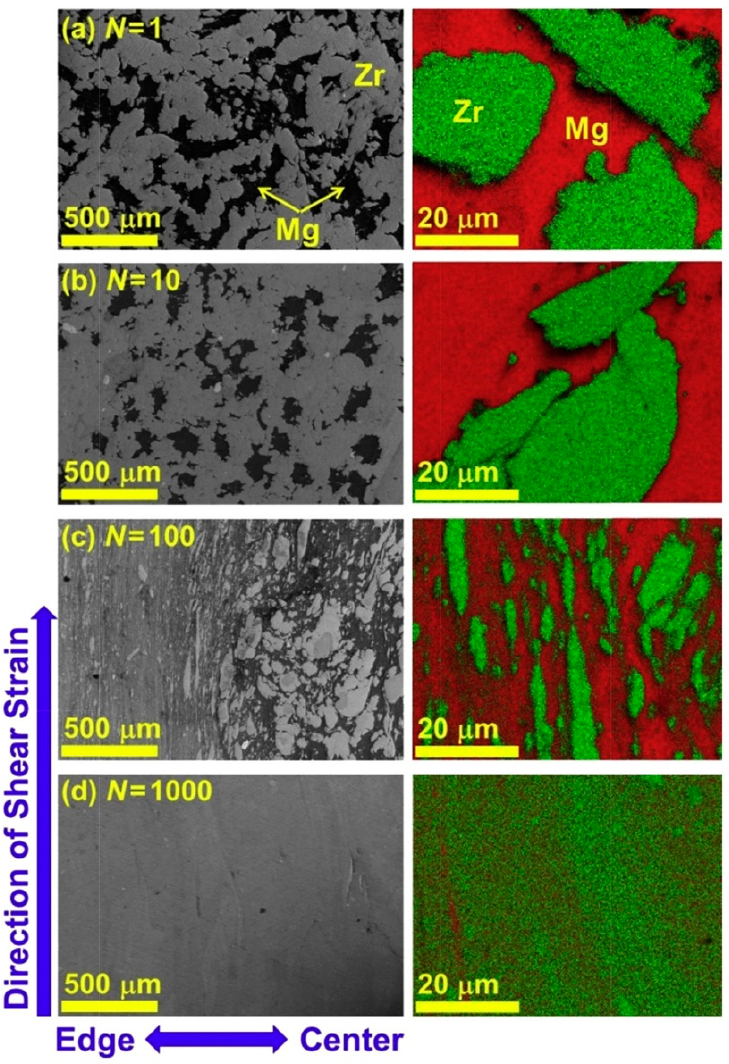
Figure 6. Scanning electron micrographs and EDS elemental mappings of the Mg-Zr alloy processed by HPT for different number of revolutions [81].